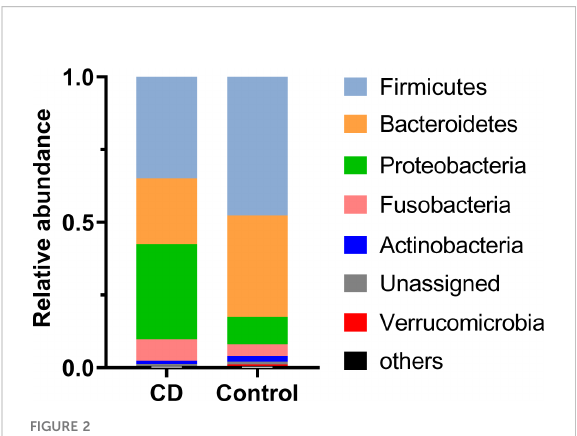
FIGURE 2 Differential phylum distribution of the gut microbiome in CD and control groups. Average relative abundances of individual phylum are plotted.